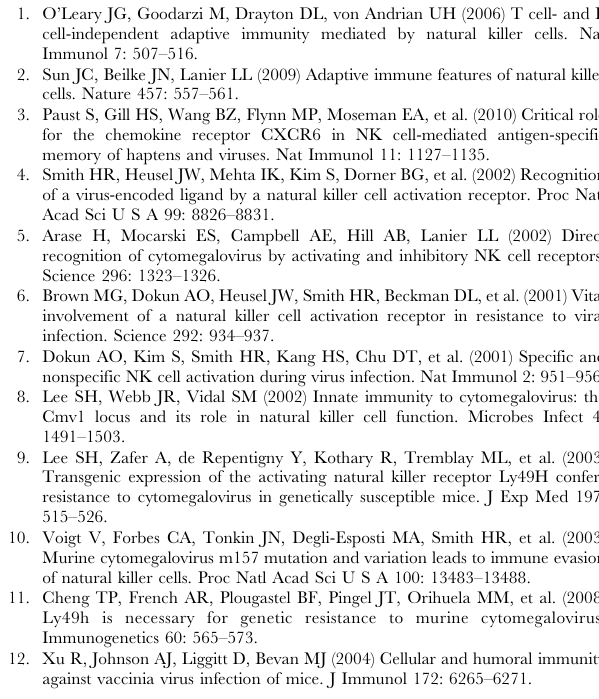
Figure S2 Representative IVIS imaging and ovarian pfu recovered from vaccinia virus-challenged IgHko mice.